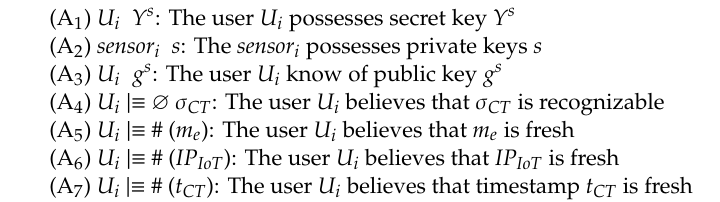
Table 2. The assumptions of the proposed protocol.